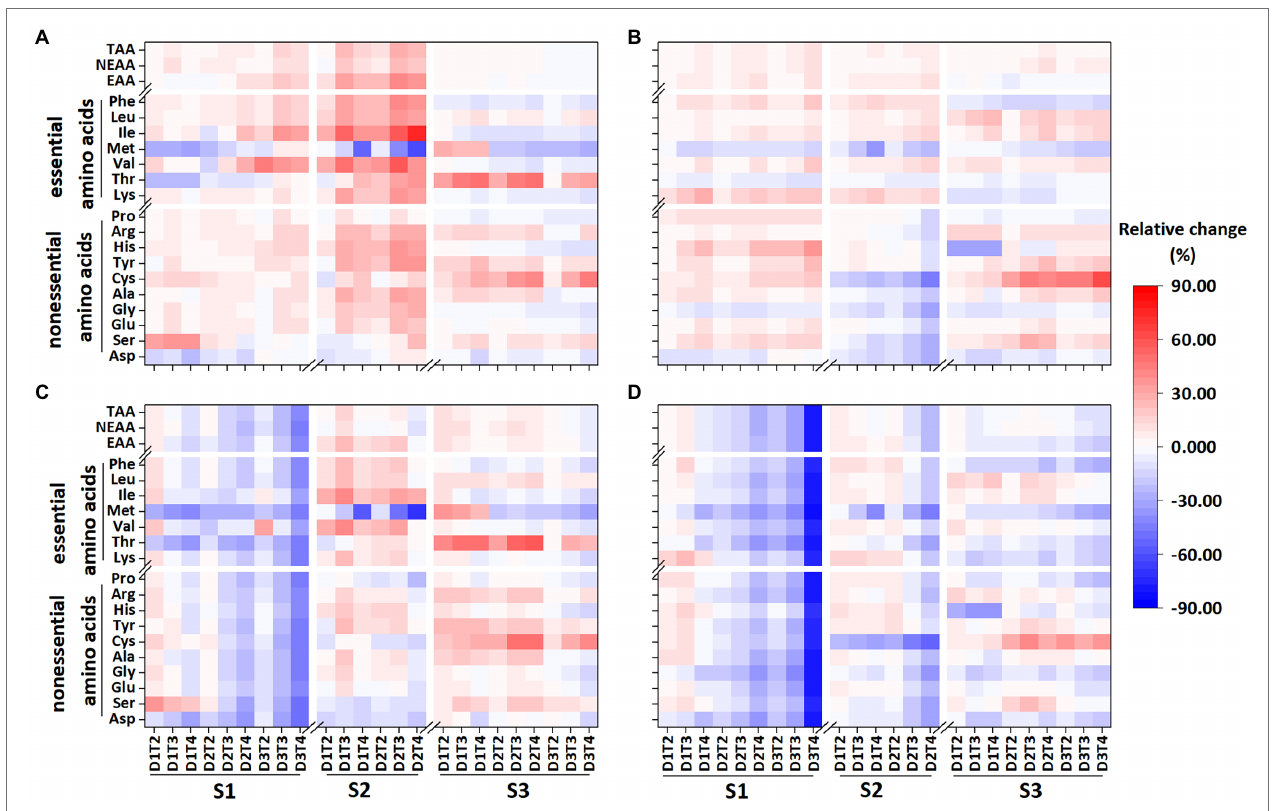
FIGURE 3 | Relative changes in amino acids content (A,B) and accumulation (C,D) under low-temperature stress in Huaidao 5 (A,C) and Nanjing 46 (B,D) at maturity in 2018. S1, S2, and S3 represent the early stage of flowering, peak stage of flowering, and grain filling stage, respectively. Thr: threonine, Val: valine, Met: methionine, Ile: isoleucine, Leu: leucine, Phe: phenylalanine, Asp: aspartic acid, Lys: lysine, Ser: serine, Glu: glutamic acid, Gly: glycine, Ala: Alanine, Cys: cysteine, Tyr: tyrosine, His: histidine, Arg: arginine, Pro: proline, EAA: total essential amino acids, NEAA: total non-essential amino acids, TAA: total amino acids. The results for 2019 and 2020 are shown in Supplementary Figures S2, S3